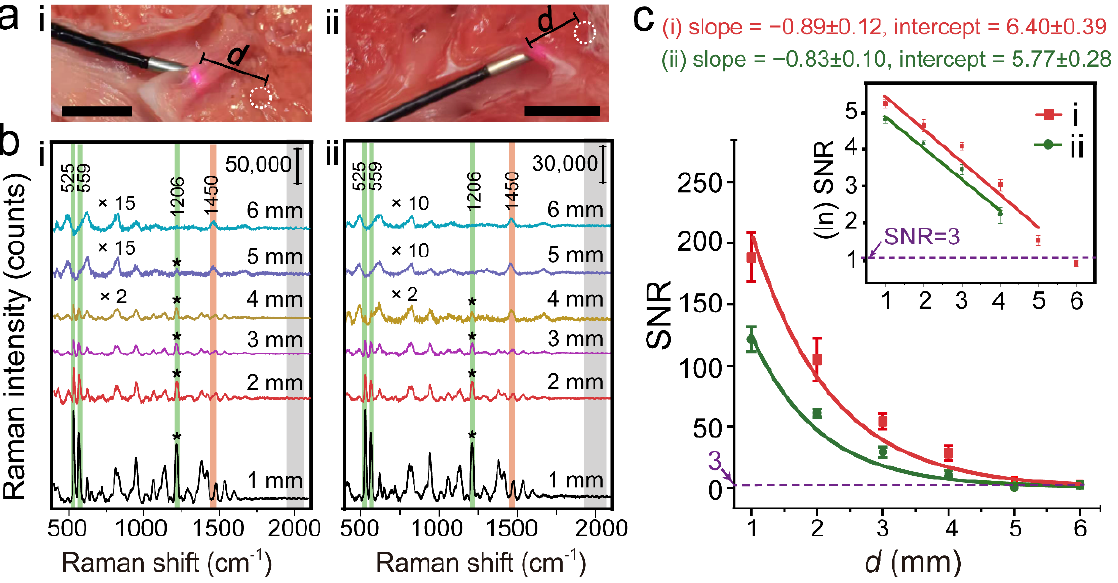
Figure 5. Quantitative assessments of Raman spectroscopic detection depth in lung tissues. ( a ) Photographs of measurements at ( i ) site i , and ( ii ) site ii . The white dashed circle indicates the location of a SERS gel at a distance ( d ) to the bronchi wall. ( b ) The Raman spectra and ( c ) SNR profile of SERS gels embedded in lung tissues at distances ( d ) from 1 to 6 mm. In ( b ), Raman peaks of SERS gels (525, 559 and 1206 cm − 1 ) are marked in green, peak of lung tissues (1450 cm − 1 ) is marked in orange, and the region (1950–2050 cm − 1 ) for noise calculation is marked in grey. The measurements were performed under 785 nm excitation (20 mW, 5 s integration time). The inset in ( c ) is plotted in an ln Y-axis, and parameters of linear fitting models are displayed, with R-squared values of 0.93 and 0.96 for the red and green line, respectively. Table 1. The thickness of bronchi wall, SERS NPs concentrations, the corresponding detection depths as well as SNR of peak 1206 cm − 1 at each